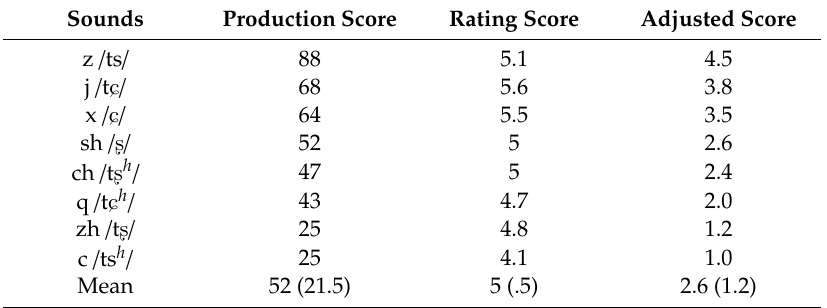
Table 6. Mean adjusted production scores (% production x rating score) of the target consonants produced by English CFL learners (N =